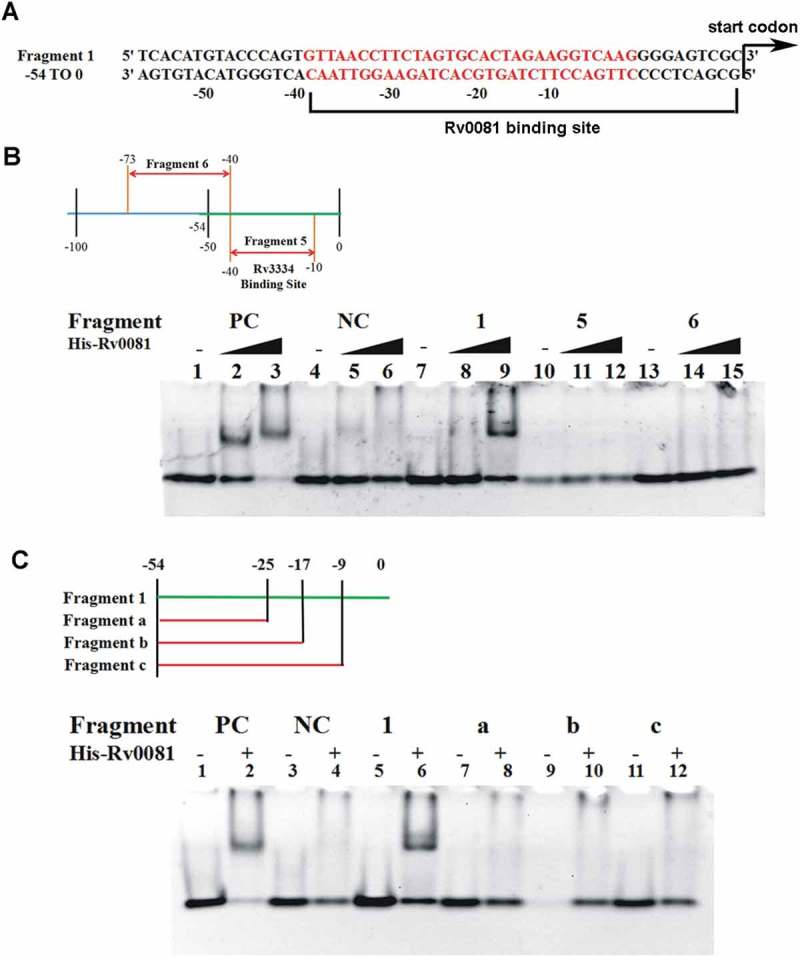
The first 10 bp and the 22 bp palindrome upstream of Rv3334 are both required for the binding of Rv0081. (a) The 22-bp palindromic sequence in the upstream region of Rv3334 was highlighted in red. The binding site of Rv0081 was indicated (−40 to −1). (b) EMSA of Fragment 5 (−40 to −10) and 6 (−73 to −40). Lanes 1 to 3: positive control DNA probe added with 0-, 288- and 576- ng Rv0081 protein, respectively; lanes 4 to 6: negative control DNA probe added with 0-, 288-, and 576- ng Rv0081, respectively; lanes 7 to 9: Fragment 1 added with 0-, 288-, and 576- ng Rv0081, respectively; lanes 10 to 12: Fragment 5 added with 0-, 288-, and 576- ng Rv0081, respectively; lanes 13 to 15: Fragment 6 added with 0-, 288-, and 576- ng Rv0081, respectively. (c) EMSA of smaller fragments: Fragment a (−54 to −25), b (−54 to −17), and c (−54 to −9). Lanes 1 & 2: positive control DNA added with 0- and 576- ng Rv0081 protein, respectively; lanes 3 & 4: negative DNA added with 0- and 576- ng Rv0081 protein, respectively; lanes 5 & 6: Fragment 1 added with 0- and 576- ng Rv0081 protein, respectively; lanes 7 & 8: Fragment an added with 0- and 576- ng Rv0081 protein, respectively; lanes 9 & 10: Fragment b added with 0- and 576- ng Rv0081 protein, respectively; lanes 11 & 12: Fragment c added with 0- and 576- ng Rv0081 protein, respectively. PC: positive control, a 59-bp DNA fragment from the upstream region of Rv0081. NC: negative control, a 40-bp fragment from the upstream of hycD.